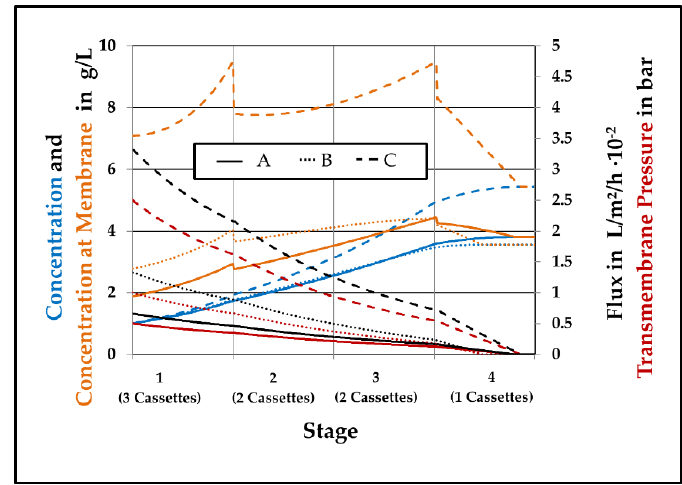
Figure 13. Calculation scenario: axial profiles of operation points A, B, C.